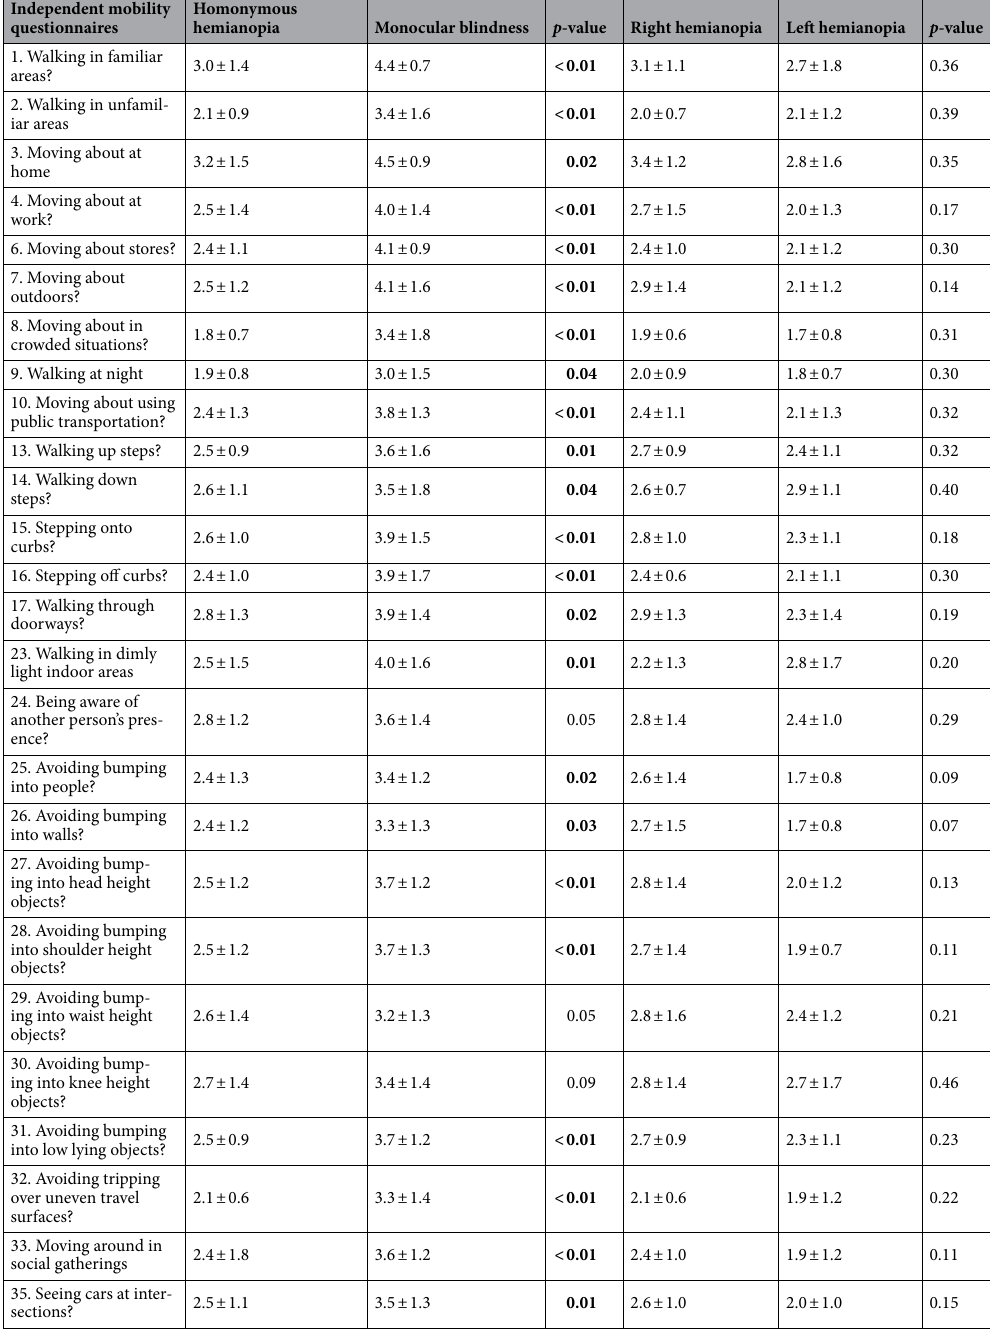
Table 3. Analysis of independent mobility questionnaire (IMQ) between homonymous hemianopia and monocular blindness